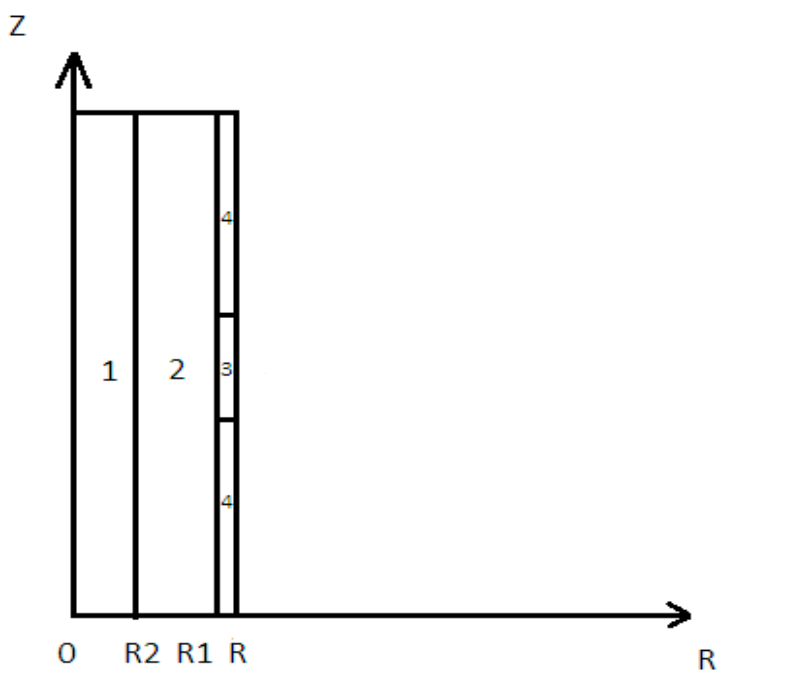
Figure 4. Geometry of the solution area.